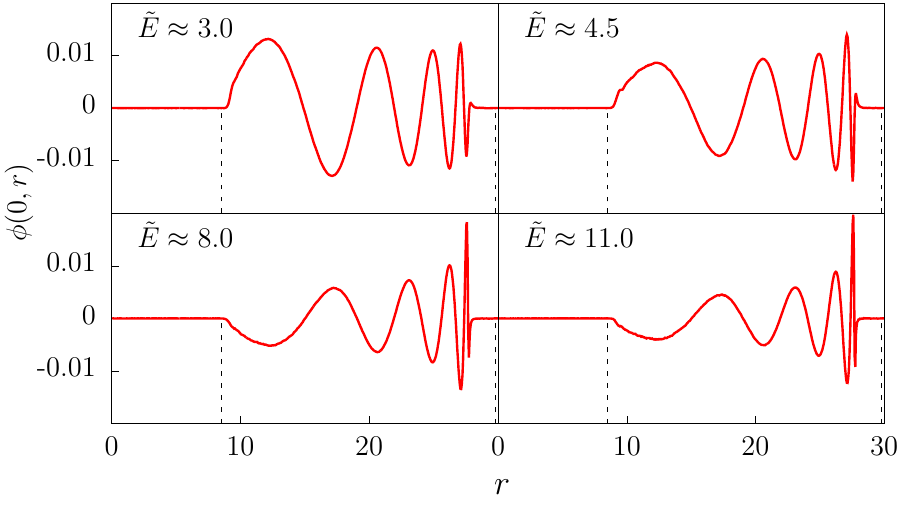
Figure 7 . The same as in (cid:12)gure 2 but for N r = 600 ; R =